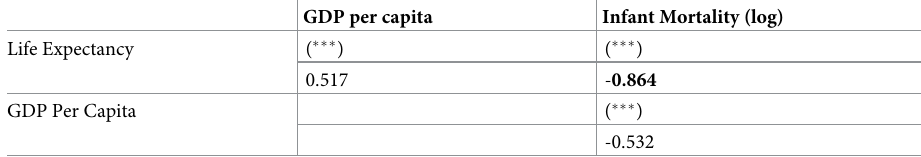
Table 3. Correlations between life expectancy , GDP per capita and infant mortality (log) .